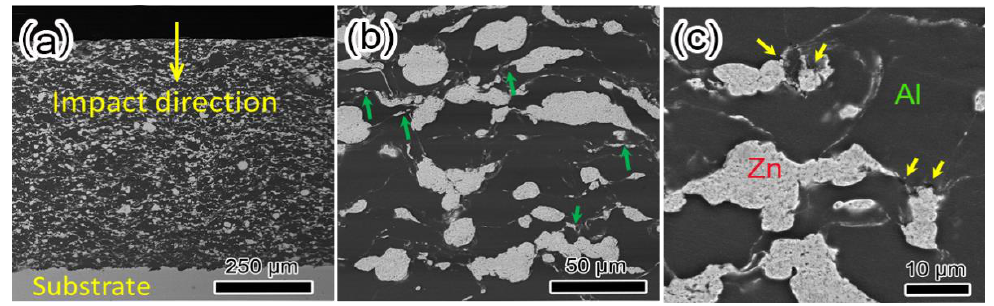
Figure 2. The Backscattered SEM images of as-sprayed Zn–Al coating at ( a ) 250×; ( b ) 500× and ( c ) 3000× magnification.